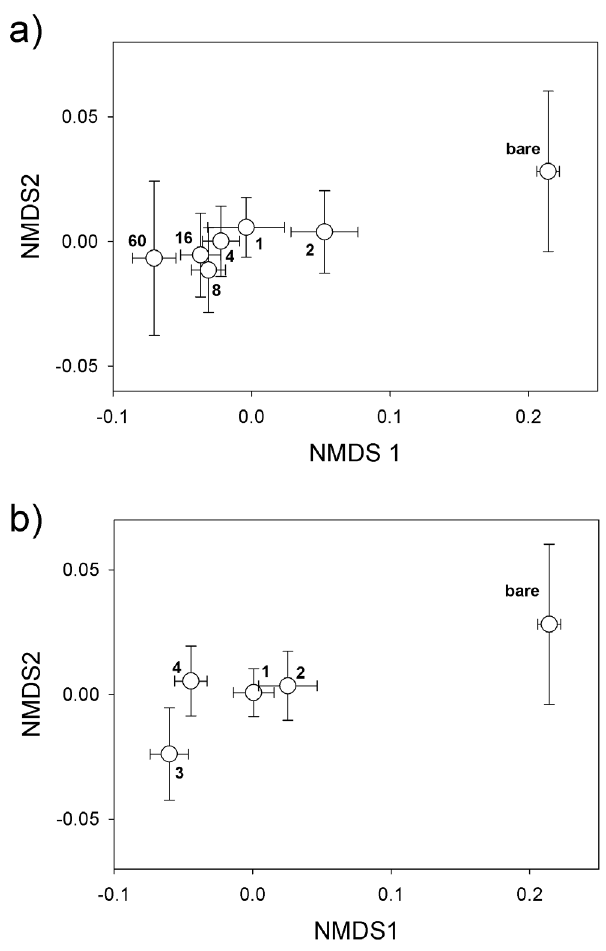
Figure 3. Summary of non-metric multidimensional scaling (NMDS) of the PLFAs. Differences among bare ground plots and different plant diversity levels are shown for (a) 1 to 60 sown plant species and (b) 1 to 4 functional groups. Bray-Curtis was used